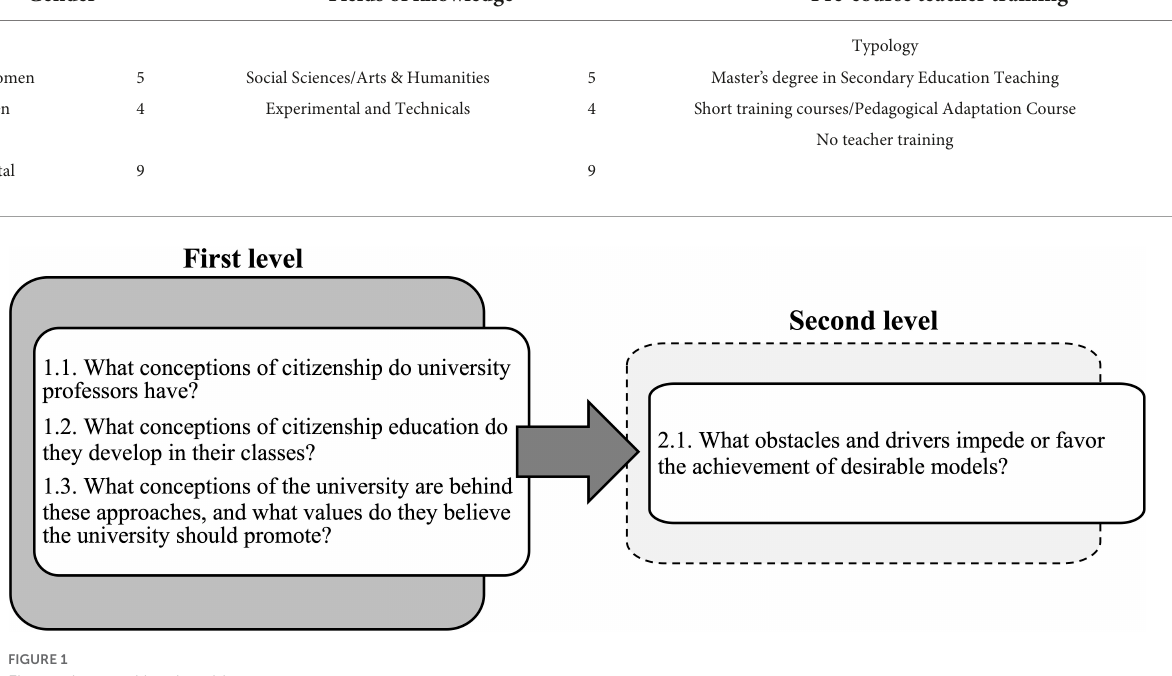
FIGURE1 First and second level